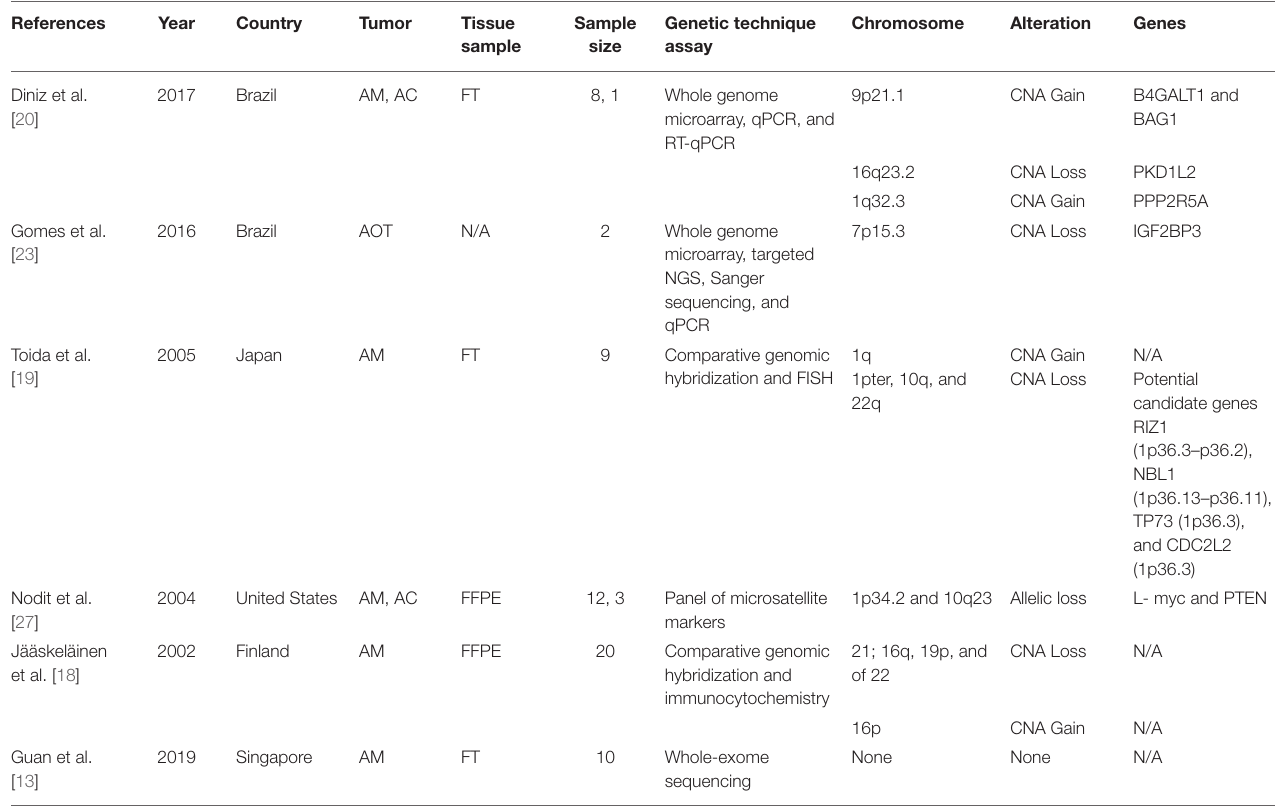
TABLE 2 | Chromosomal alterations in AOT and